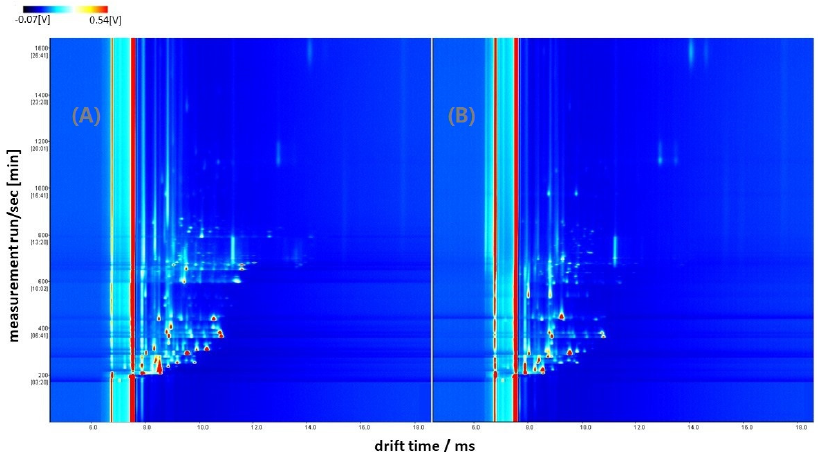
Figure 1. Topographic plots of GC–IMS spectra obtained for acorn-fed ( A ) and supplementation ( B ) samples.